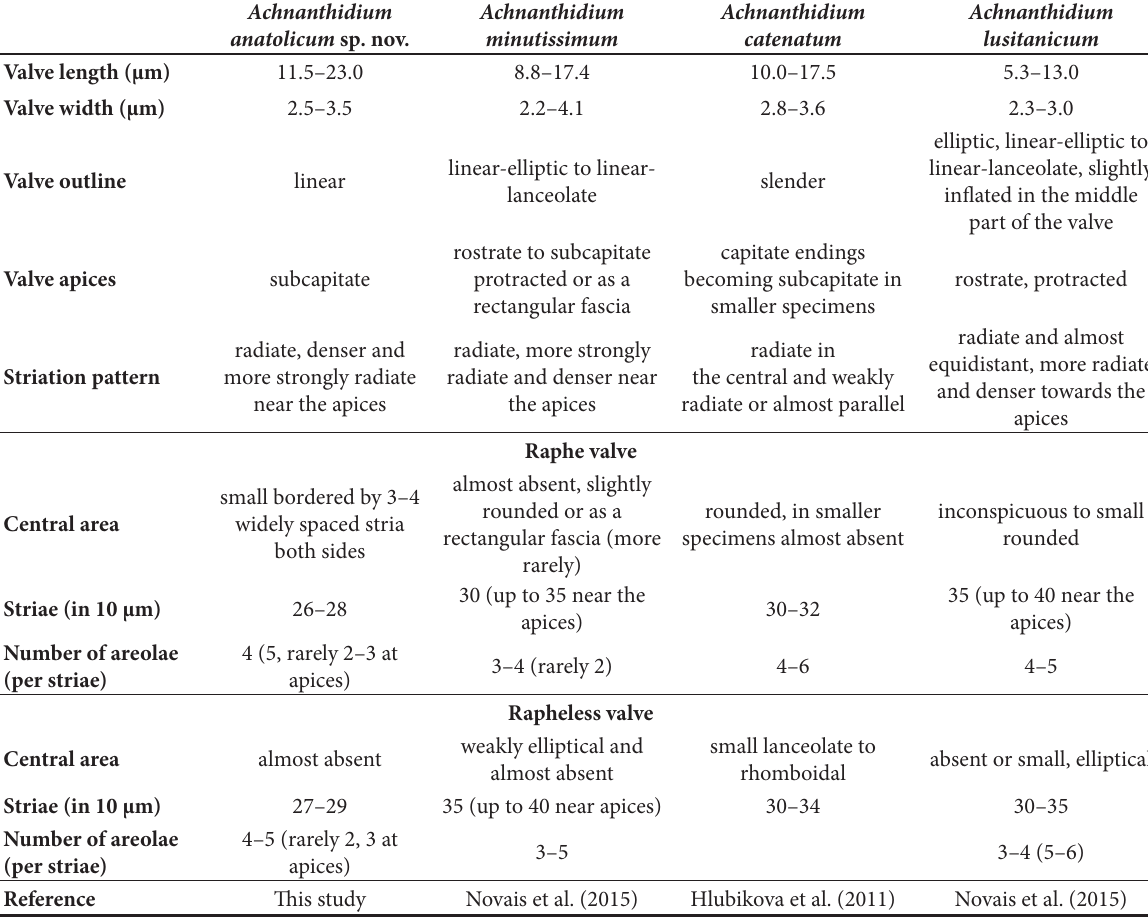
Table 2. Comparison morphological characteristics of Achnanthidium anatolicum sp. nov. and morphologically similar